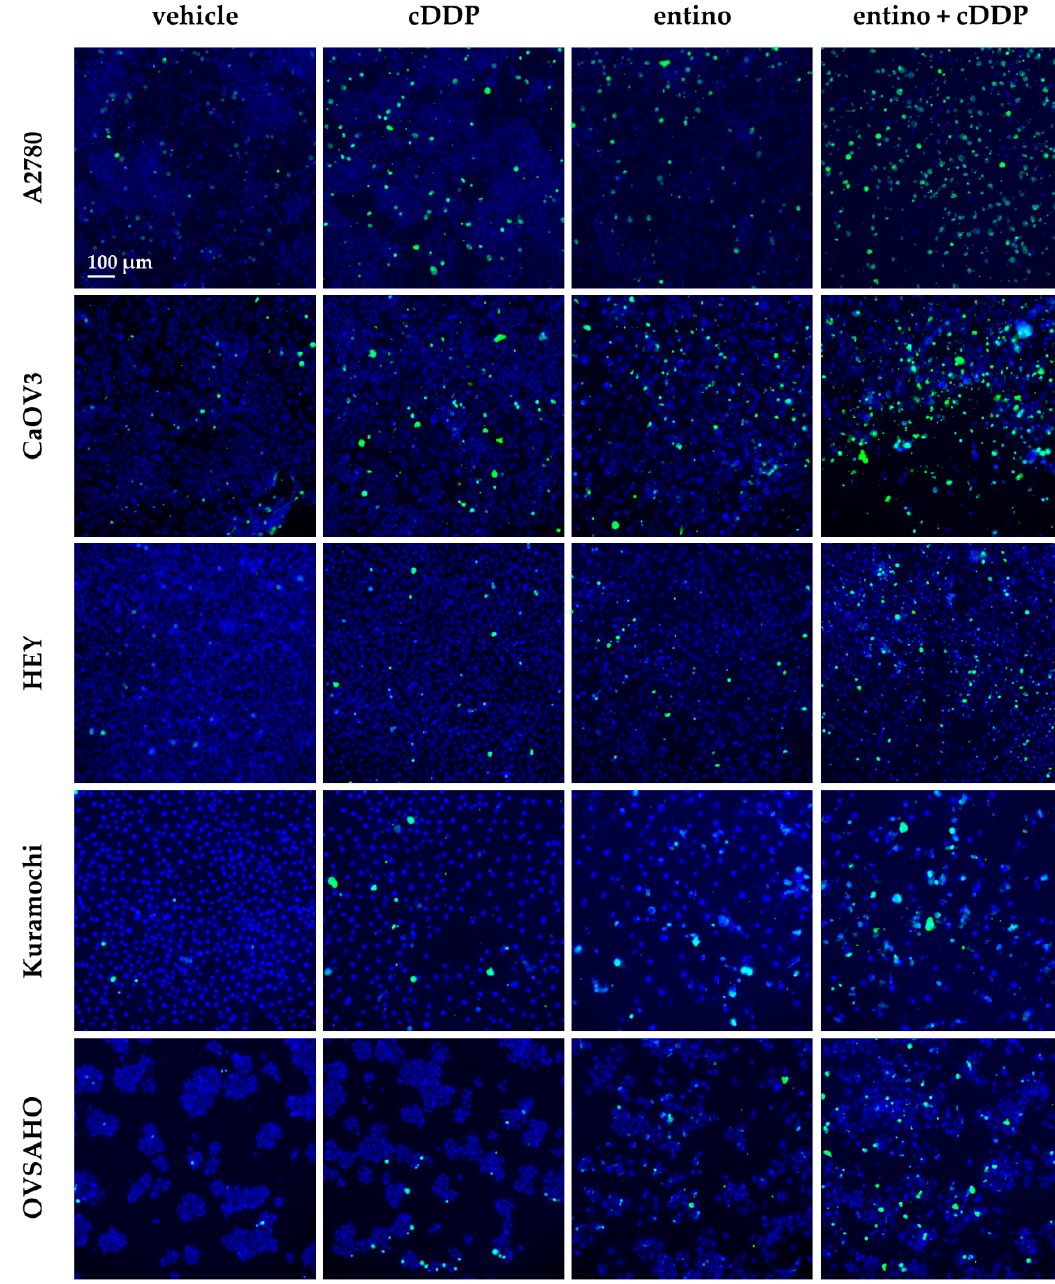
Figure 6. Representative fluorescent imaging pictures (10 × magnification) are shown for each cell line for the treatment of cisplatin (IC 50 concentration), entinostat, and the combination of cisplatin and entinostat. Cell nuclei were stained by Hoechst 33342 and appear blue while cells with activated caspases3 / 7 showed green fluorescence. Scale bar in upper left image is 100 µ m and applies to all images.